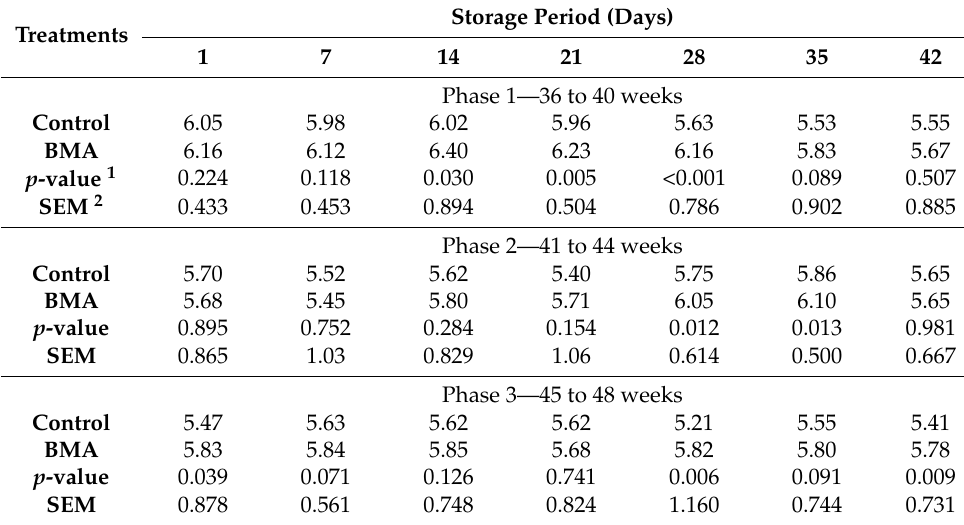
Table 7. Yolk yellowness (a* color) of eggs from laying hens fed with β -mannanase depending on storage